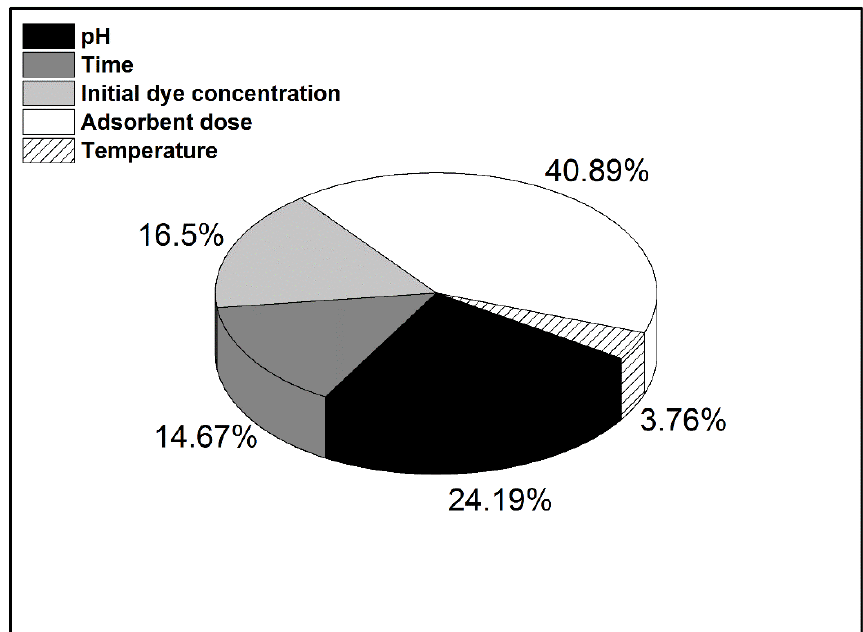
Figure 4. Specific influence of controllable factors on the adsorption process.